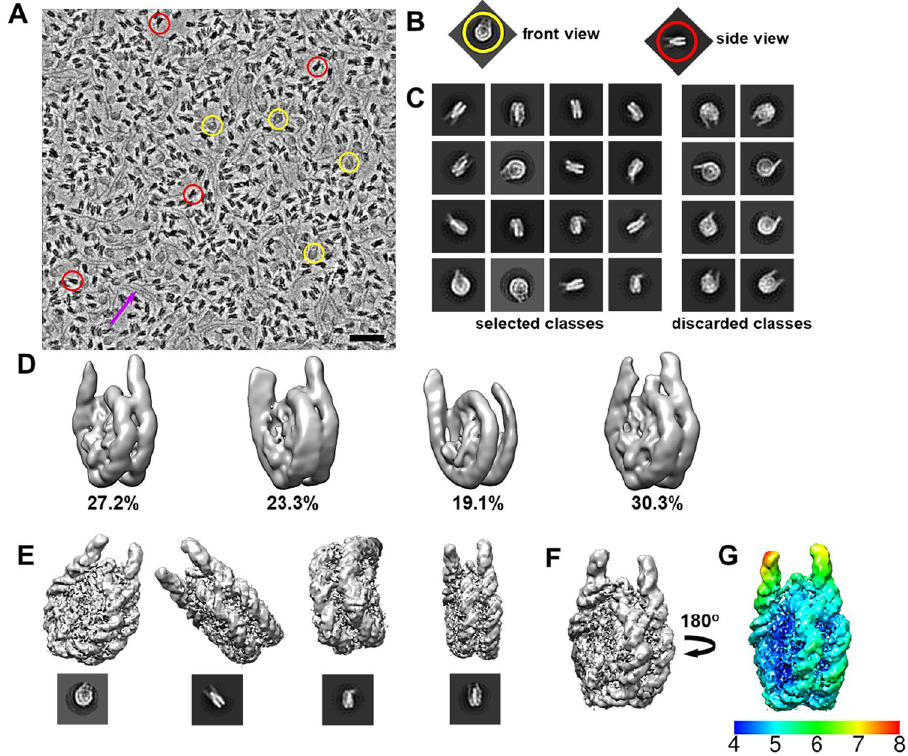
Figure 3. Cryo-EM processing for the 601–177 human chromatosome. ( A ) A representative electron micrograph of the 601–177 chromatosome recorded with the Volta phase plate at 500 nm defocus. The arrow points at free DNA. The scale bar is 40 nm. ( B ) Representative 2D class averages of the chromatosome generated in RELION 3.0 ( C ) Typical disk and side view 2D class averages. The corresponding particle views in the micrograph are circled. ( D ) Representative 3D class averages obtained from 168,042 particles selected from the 2D classification. ( E ) EM map of the chromatosome after 3D refinement of the right-hand 3D class comprising 46,196 particles. Different views are shown. The filtered local res map is shown at a contour level of 0.0205. The corresponding 2D class averages are placed below. ( F ) Cryo-EM map of the final 601–177 chromatosome after refinement. ( G ) Local resolution estimated in RELION 82,99 . The volumes maps were calculated by RELION 82,99 (www3.mrc-lmb.cam.ac.uk/relio n/index .php/Main_Page) and visualised using CHIMERA 83,84,94 (www.rbvi.ucsf. edu/chime